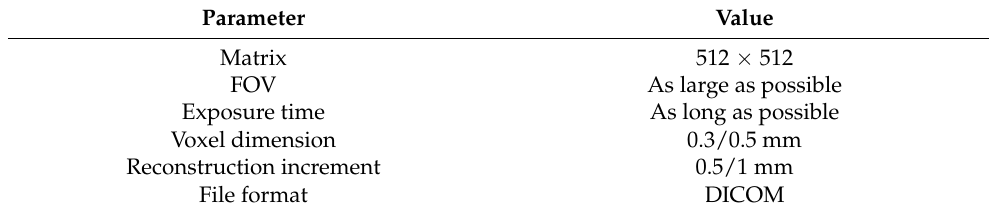
Table 1. Standard setting of